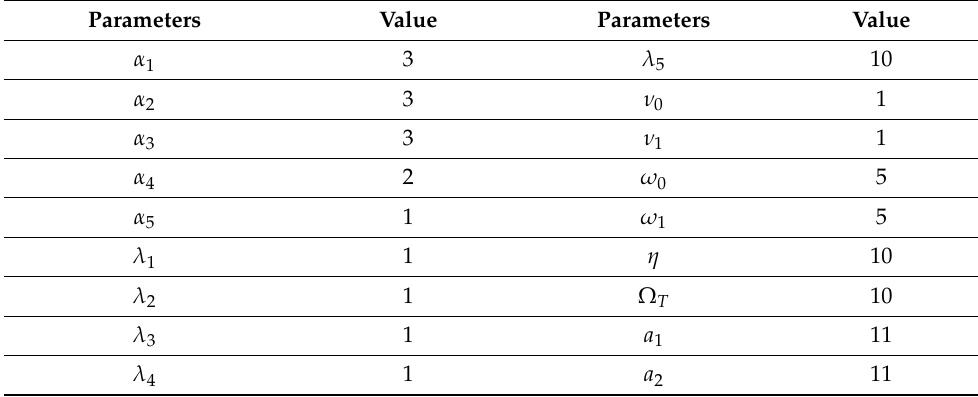
Table 1. Proposed control tuning